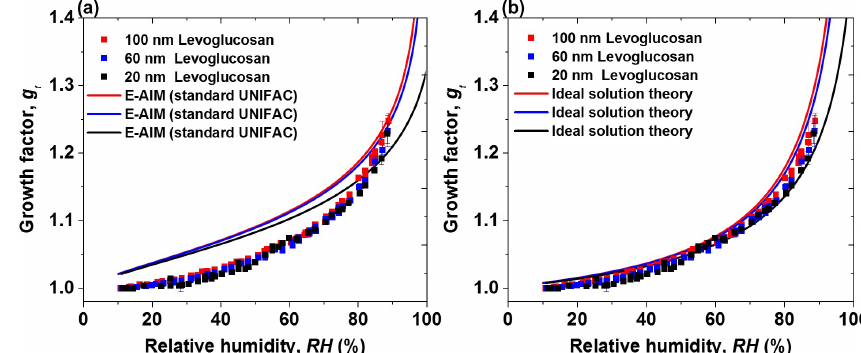
Figure 4. Hygroscopic diameter growth factor ( G f ) of levoglucosan particles with dry diameters of 100nm (red square), 60nm (blue square), and 20nm (green square). Köhler model curves are based on (a) E-AIM (standard UNIFAC) (100nm: red, 60nm: blue, 20nm: green line) and (b) ideal solution theory (100nm: red, 60nm: blue, 20nm: green line).